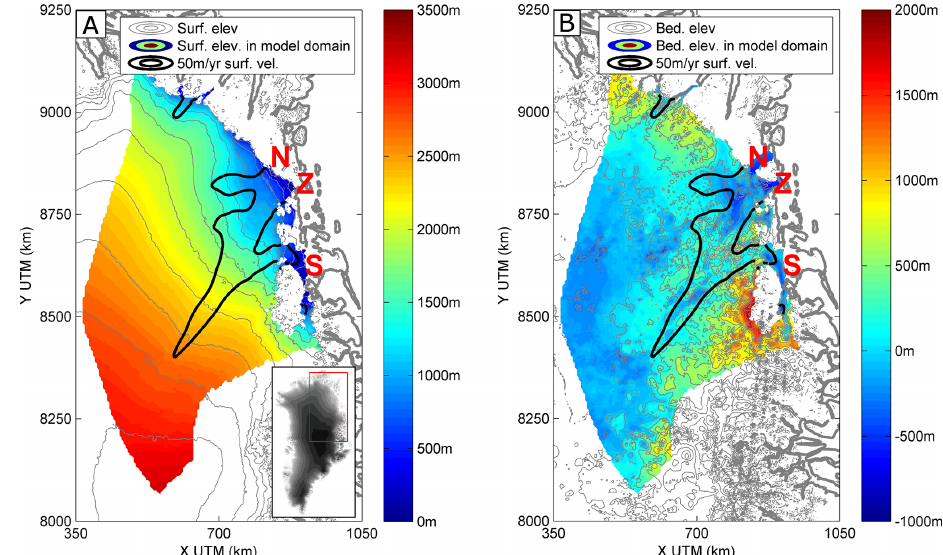
Figure 1. Surface (a) and bed elevation (b) (Bamber et al., 2013a) in grey contours. N stands for Nioghalvfjerdsbræ, Z for Zachariae Isstrøm and S for Storstrømmen. The 5km model domain for the Northeast Greenland drainage basin is shown in colours, and the contour for the 50myr − 1 surface velocity (from Joughin et al., 2010) is indicated with thick, black